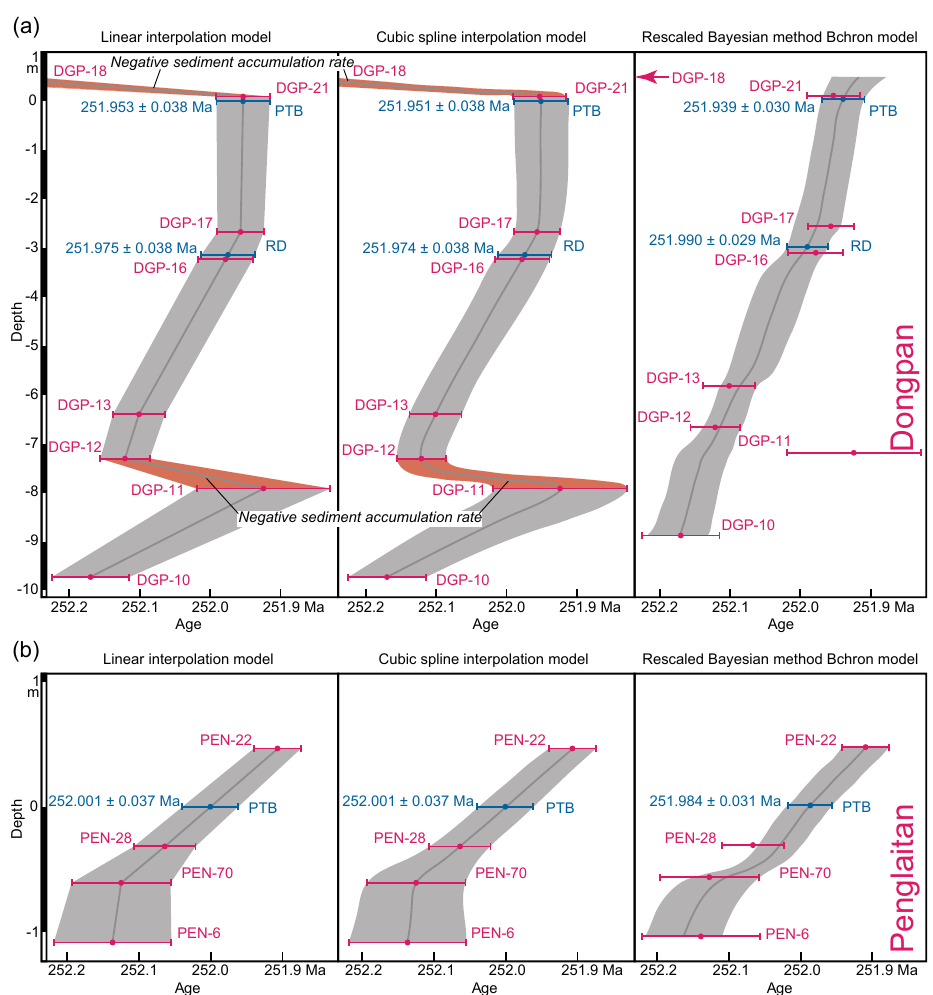
Figure 5. Comparison of the different age–depth models based on linear interpolation, cubic spline fit and Bayesian statistics for (a) Dongpan and (b) Penglaitan. Each age–depth model is presented with its median (middle grey line) and its associated 95% confidence interval (grey area). Radioisotopic dates, used in the age–depth models, together with their uncertainty (red horizontal bars) are presented as 206 Pb / 238 U weighted mean dates of the Dongpan and Penglaitan volcanic ash beds and volcanogenic sandstones in their stratigraphic positions. U-Pb data of DGP-21, PEN-28 and PEN-22 are taken from Baresel et al. (2016). Predicted dates (blue horizontal bars) for the onset of the radiolarian decline (RD) and the Permian–Triassic boundary (PTB) in Dongpan and Penglaitan are calculated with their associated uncertainty using the different age–depth